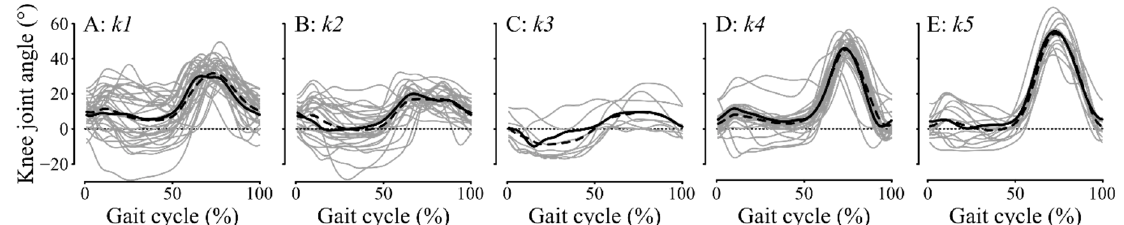
Figure 2. Sagittal knee joint angle for a complete gait cycle. Subplots are: ( A ) k 1 or UKG, ( B ) k 2 or BKG, ( C ) k 3 or FLG, ( D ) k4 or healthy, ( E ) k 5 or non-SKG. Individual kinematics are plotted in grey lines, mean kinematics for each cluster are in black dashed lines, and medoids are in continuous black lines. Clustering results were compared with the CHGC and the Goldberg index (Table 3). A total of 30 out of 115 gait patterns were misclassified (26.1% of errors) between the Goldberg index and the clusters (Table 3: k1-k2-k3 while the index was ≤ 2). Only 7 were misclassified (6.1% of errors) between the CHGC and the clusters (Table 3: k1 but G0 and GI and k4 - k5 but GII or GIII ). Thus, k4 and k5 included mainly hemiparetic adults classified as GI and healthy subjects, whereas the other three SKG groups included mainly GII and GIII patients. Moreover, the more severe clusters, k2 and k3 , only contained GII and GIII patients and had a higher median Goldberg index (score = 3) compared to k1 (score = 2). In all, the comparisons between the clusters and the CHGC or Goldberg index results provided proof of construct validity of the proposed SKG classification. Table 3. Comparison of SKG classification following Goldberg index (i.e., SKG if score > 2) and CHGC (i.e., SKG for groups GII and GIII ) versus clustering (i.e., SKG for k1 to k3 ). Misclassifications are highlighted in grey and overall error rates are given for both methods.